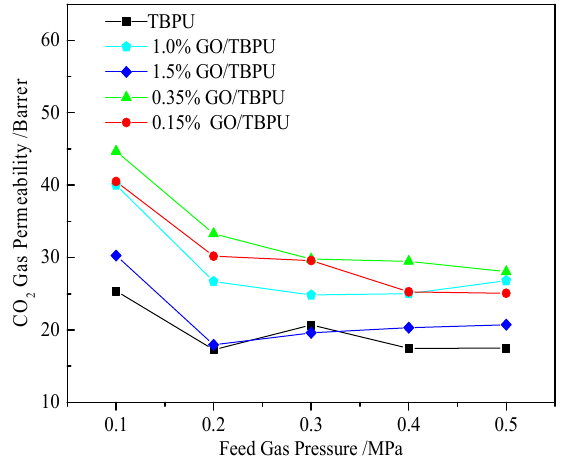
Figure 8. CO 2 permeability of different GO-TBPU membranes under different pressures.